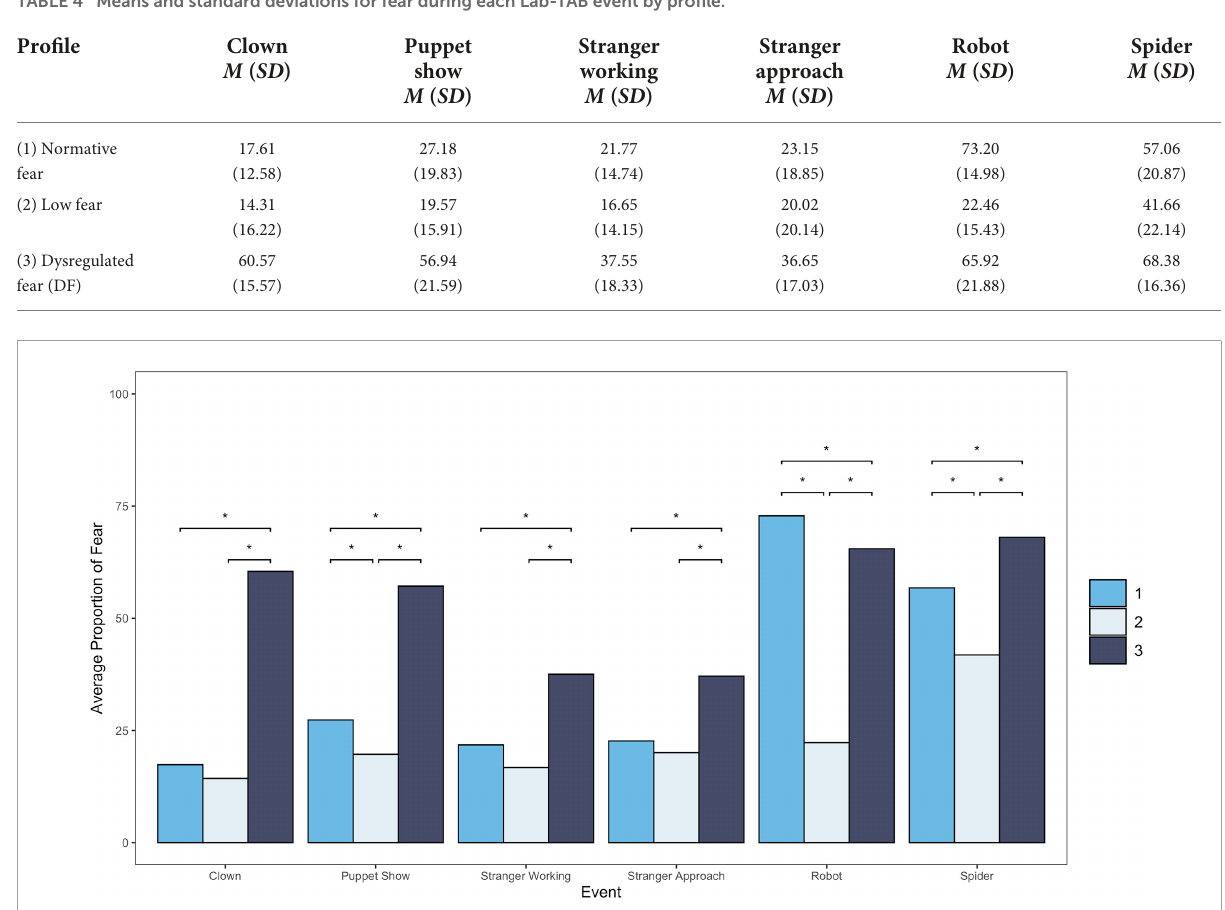
FIGURE1 Bar chart showing average proportion of fear for each event by profile, with significant differences between profiles indicated. * p < 0.05.